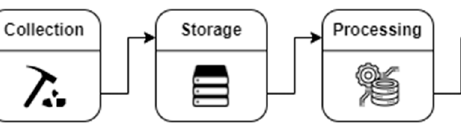
Figure 1. Big Data lifecycle.